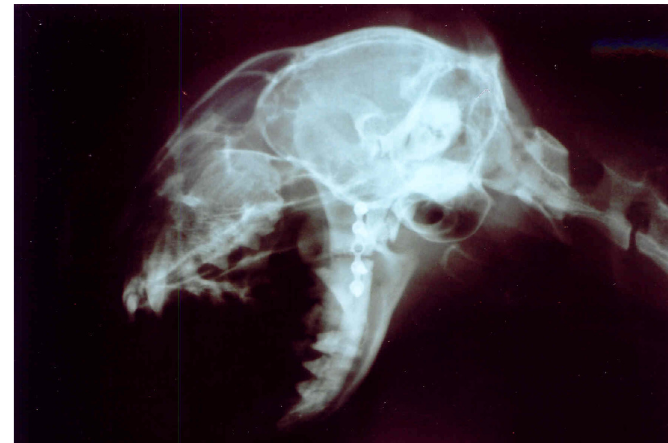
FIGURE 3 - Radiograph in oblique lateral projection taken 1 week after surgery shows the radiolucent line corresponding to the osteotomy. Cat 3 of Group 1.